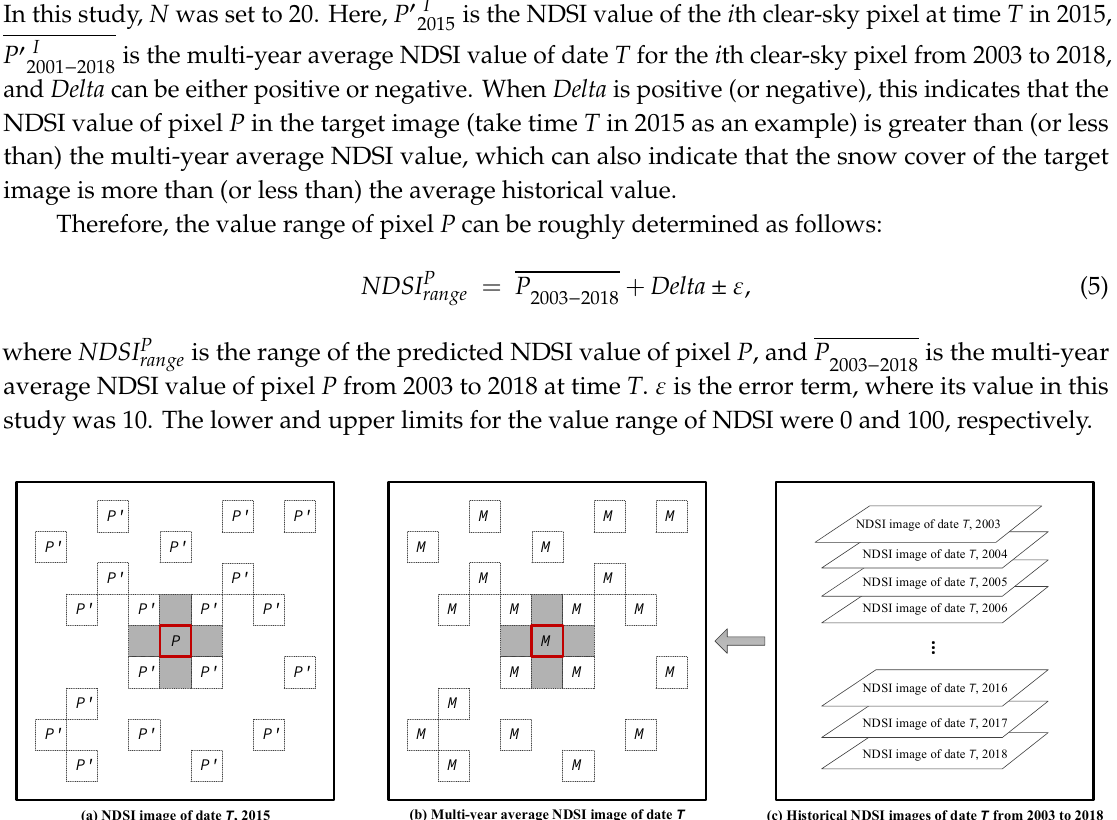
Figure 4. Sketch map for calculating the range of the predicted NDSI value. ( a ) NDSI image from date T in 2015 as an example, in which P is a cloudy pixel and P’ indicates the closest N cloud-free pixels surrounding P ( N was set to 20 in this study). ( b ) Multi-year average NDSI image from date T , in which M indicates the multi-year average NDSI value for each pixel. The information in ( b ) was calculated using ( c ) the historical NDSI images of date T from 2003 to 2018.